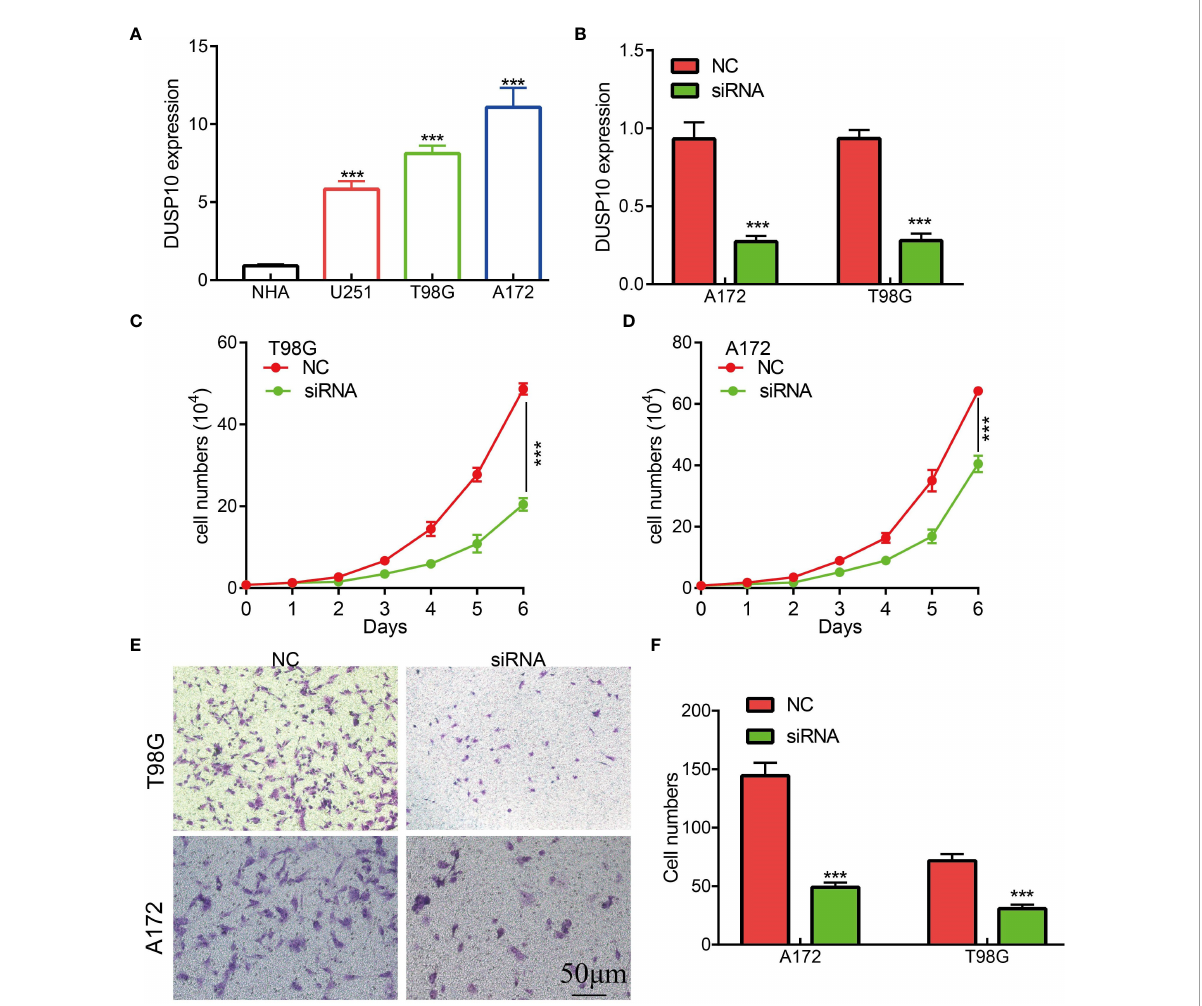
FIGURE 9 Knockdown of DUSP10 inhibited glioma cell growth and migration. (A) qRT-PCR assay indicated that the expression of DUSP10 was upregulated in glioma cells compared with that in normal human astrocyte (NHA) cells. (B) The DUSP10 knockdown ef fi ciency of different siRNAs in A172 and T98G cells. (C – F) Knockdown of DUSP10 signi fi cantly decreased the growth and migration capabilities of glioma cells. NC, negative control; siRNA, DUSP10 siRNA. *** p < 0.001.